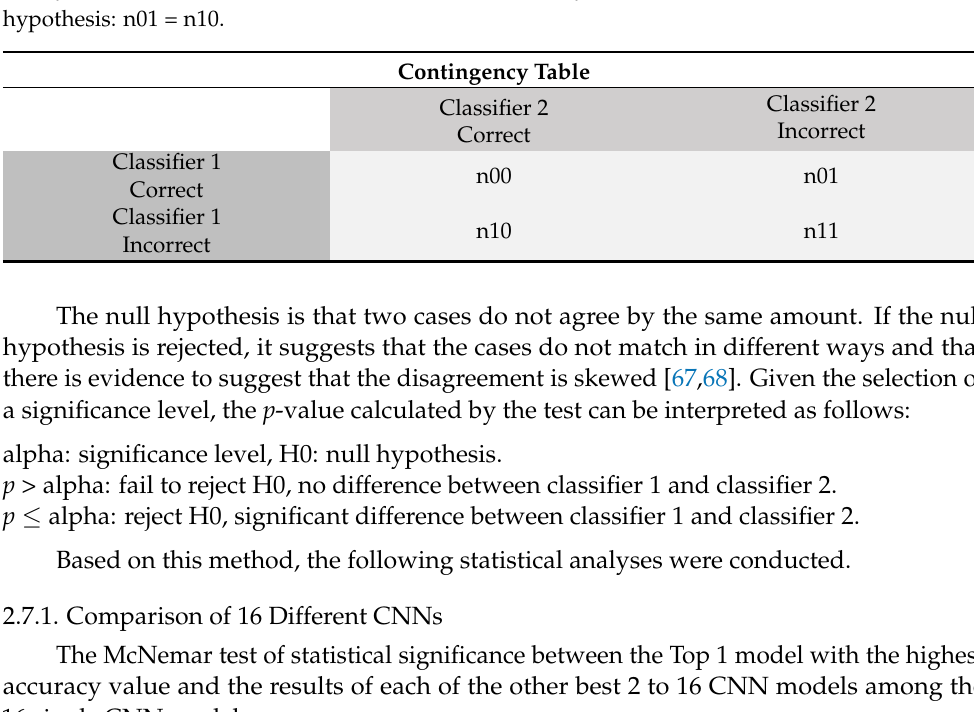
Table 2. Contingency table used for the McNemar’s test to compare two classifiers. n00: number of items classified correctly by both Classifier 1 and Classifier 2, n01: number of items classified correctly by Classifier 1 but not by Classifier 2, n10: number of items classified correctly by Classifier 2 but not by Classifier 1, n11: number of items misclassified by both Classifier 1 and Classifier 2. Null hypothesis: n01 = n10.